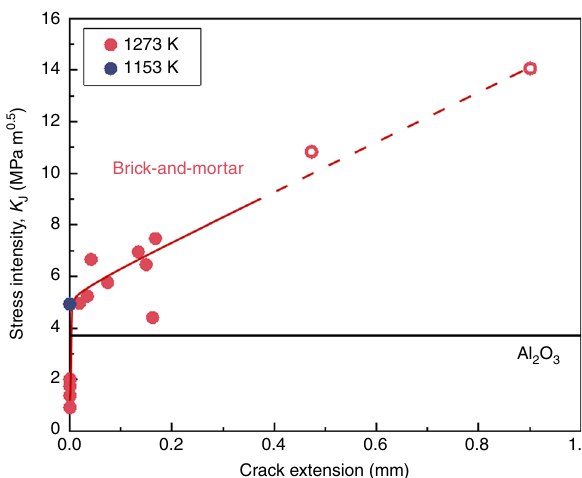
Fig. 7 Crack-resistance curves (R-curves) for brick-and-mortar alumina/ BMG-forming materials in fi ltrated at 1273 K. The onset of crack initiation and immediate catastrophic fracture of samples in fi ltrated at 1153 K is included for reference. Comparison of the fracture toughness between the samples in fi ltrated at the two in fi ltration temperatures indicates how an appropriately created brick-and-mortar microstructure can serve to stabilize the slow growth of incipient cracks, manifested in the form of a rising R-curve, rather than leading to unstable catastrophic fracture at the onset of crack initiation. (The open circles refer to data points that are not strictly valid according to ASTM Standard E1820 49 , as they exceed the maximum crack extension capacity for the test specimens that were